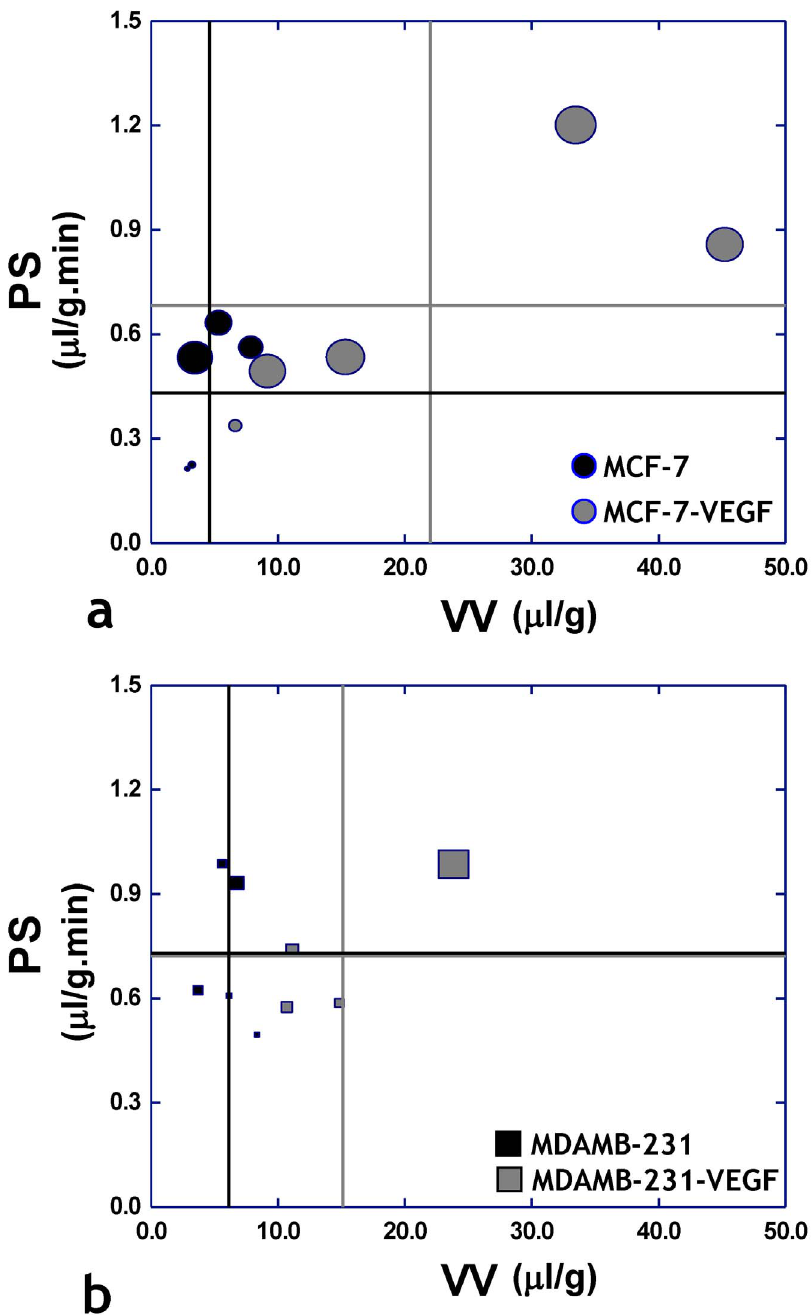
Figure 8. ‘‘MRI phenotyping’’ reveals progression of the non-invasive MCF-7 human breast cancer model to the metastatic phenotype is driven by VEGF overexpression. Scatter plots of permeability-surface area (PS) product versus vascular volume (VV) for each tumor type, in which each symbol is scaled according to the volume of extravascular fluid drained. The vertical lines represent the mean value of VV for each tumor type, while the horizontal lines represent the mean value of PS for each tumor type. (a) Scatter plot of parameters measured in vivo from MCF-7 (n=5) and MCF-7-VEGF (n=5) tumors reveal a trend in the MCF-7-VEGF group towards elevated PS and VV values (gray crosshairs) in conjunction with greater extravascular fluid drainage (larger symbol size) – which collectively indicate the progression of the original MCF-7 phenotype to a metastatic one. In contrast, (b) a scatter plot of parameters measured in vivo from MDA-MB-231 (n=5) and MDA-MB-231-VEGF (n=4) tumors does not show this trend, but shows the elevation of VV in the MDA-MB-231-VEGF tumors. doi:10.1371/journal.pone.0063146.g008 17B-estradiol pellet (0.18 mg/pellet, 60 day release, Innovative Research of America, Sarasota, FL) was inserted in the right Tumors were imaged in vivo 5–6 weeks post-inoculation, on a flank using a trocar. 4.7 T Bruker instrument using a RF coil around the animal’s torso. The tail vein of each animal was cannulated for i.v. administration